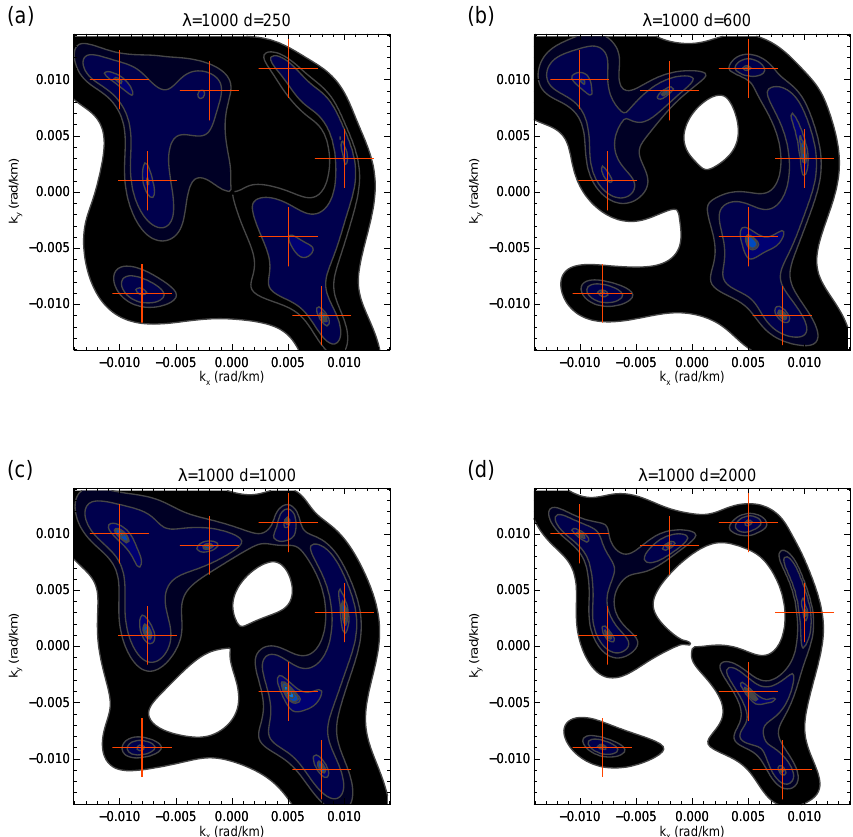
Figure 5. Estimated P(ω, k ) for eight coherent structures for a variety of ratios of d/λ . Note that the estimation is broadened as the d becomes very small relative to λ . The contours denote the same as in Fig.